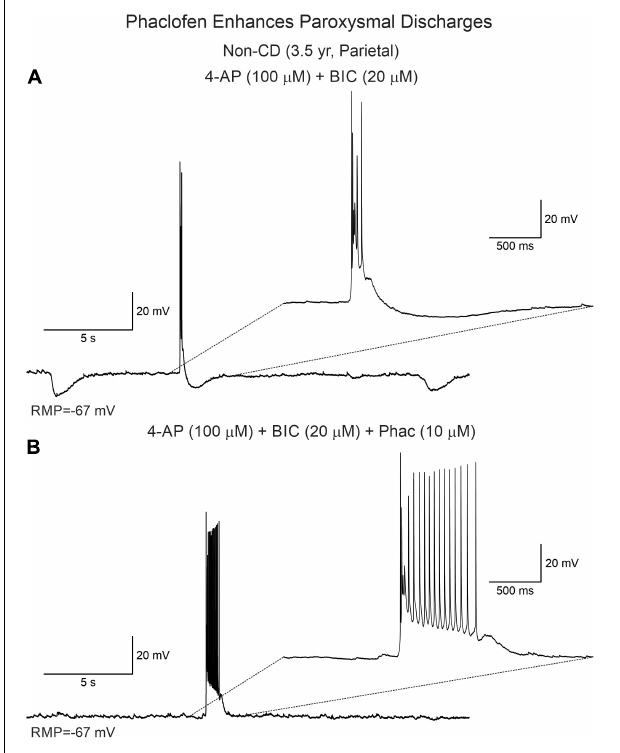
FIGURE 8 | Phaclofen enhances paroxysmal activity. (A) In current clamp mode, paroxysmal discharges were induced by combined application of 4-AP and BIC. (B) After addition of phaclofen, burst duration was